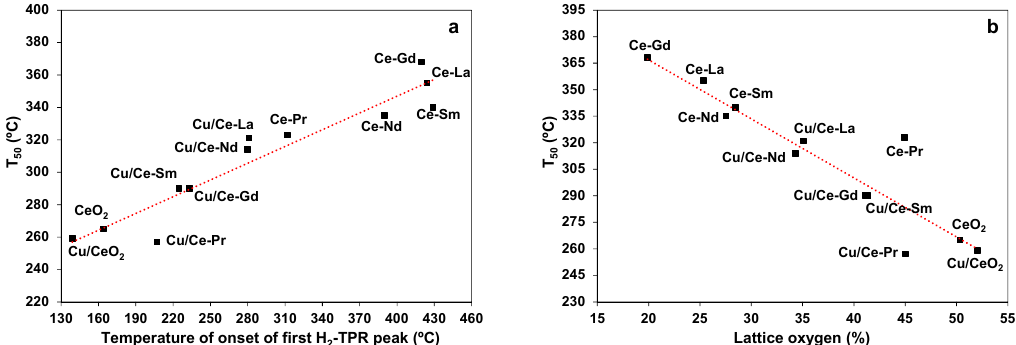
Figure 10. Correlation of 50% conversion temperature (T 50 ) with: ( a ) the onset temperature of the first H 2 -TPR peak and ( b ) the amount of lattice oxygen for Ce-Ln and Cu/Ce-Ln samples (Ln: Gd, La, Pr, Nd, Sm). The error for catalytic experiments is ±2 °C, for TPRs ±5 °C and for lattice oxygen amount ±2%.